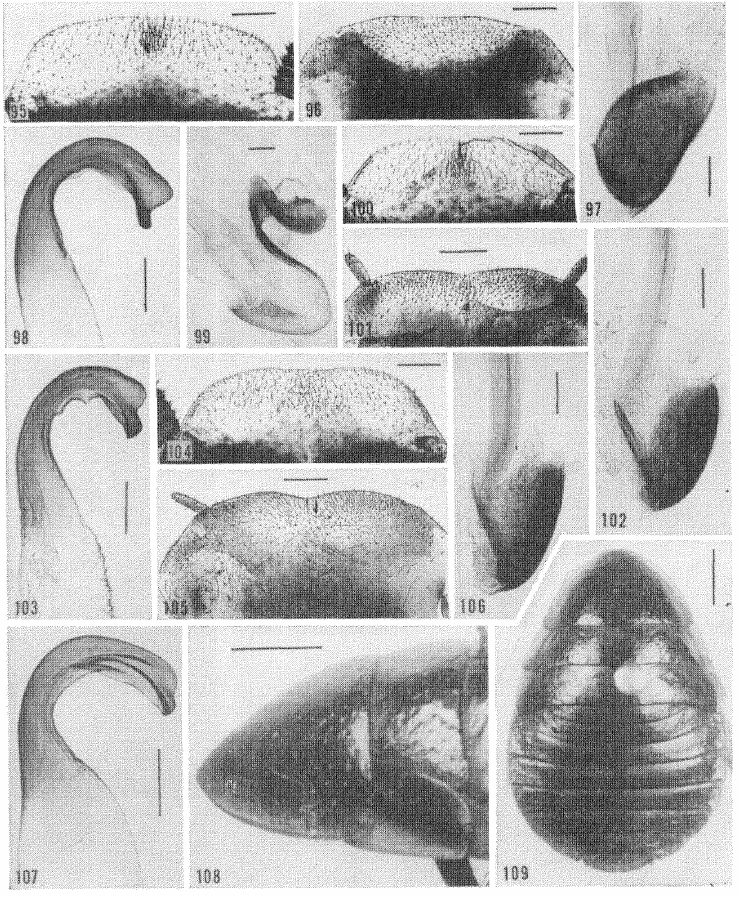
Figures 95-109. Calolamlbra atra. 95-99. (22 SAM), Mannum, S. A. 95-96. Supra-anal plate and hypandrium. 97-99. Genitalia. 100-103. (29 SAM), Adelaide, S. A. 100-101. Supra-anal plate and hypandrium. 102-103. Genitalia. 104-107 4 (30 SAM), Lucindale. 104-105. Supra-anal plate and hypandrium. 106-107. Genitalia. 108-109. 9 (1 SAM), lectotype, Sedan, S. A. 108. Lateral view of pronotum, mesonotum, and tegmen. 109. Dorsal view. Scale: Figs. 95-96, 100-101, 104-105 0.5 ram; Figs. 97-99, 102-103, 106-107 0.2 mm; Fig. 108 mm; Fig. 109 4